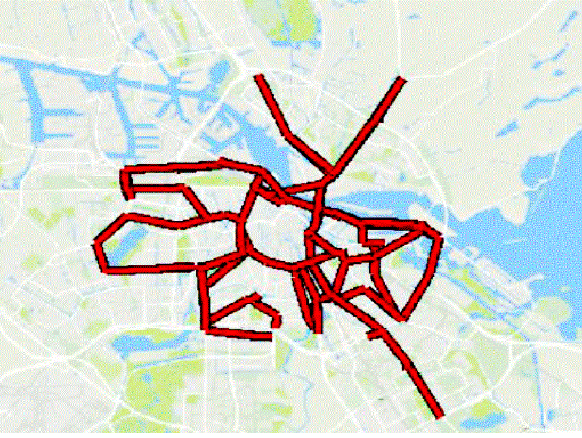
Figure 7. Amsterdam reduced network with 208 roads